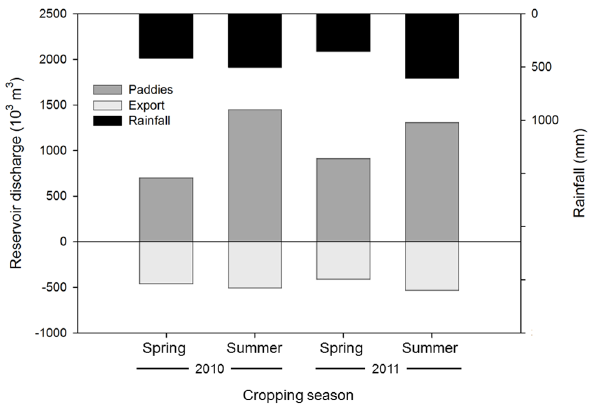
Figure 2. Total discharge from the reservoir irrigated to the 13ha paddy area draining between Locations A and B in the river, and total discharge exported (negative on the y axis) from the subwater- shed via the irrigation channel at Location 3, per rice crop (spring, summer) per year, and amount of rainfall per rice crop per year.